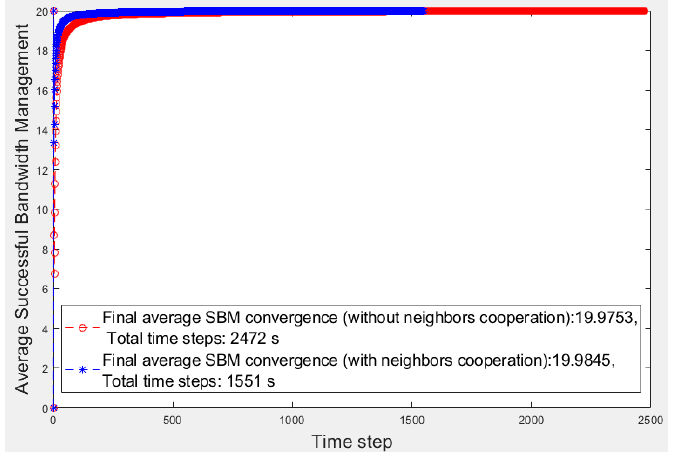
Figure 3. Final average successful bandwidth management (SBM) of the fog nodes without and with cooperation with neighbors.